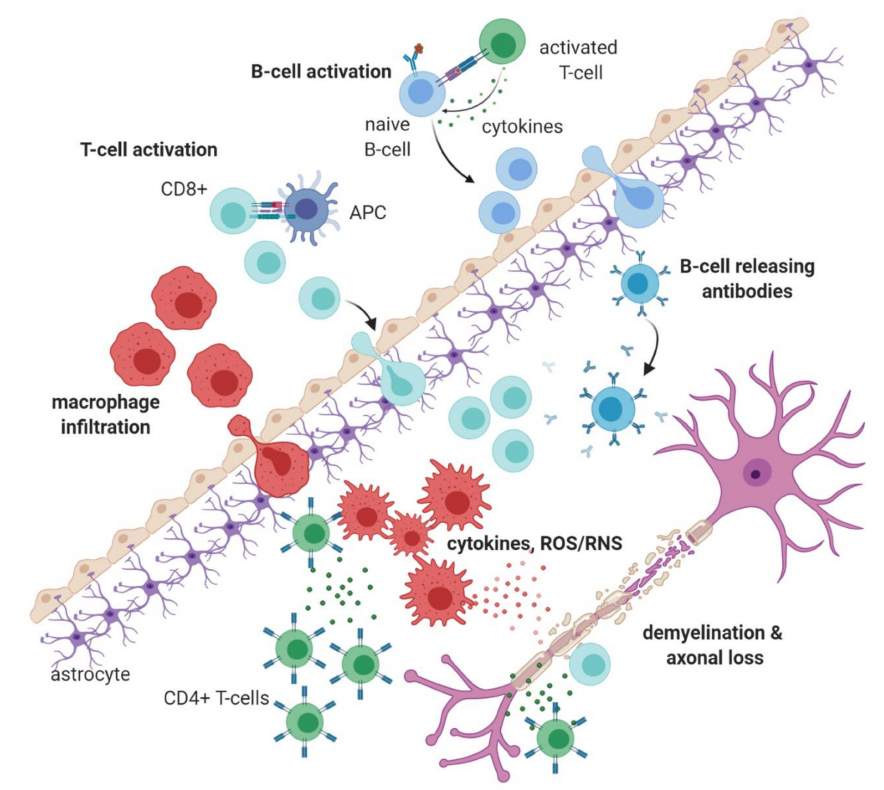
Figure 1. An outline of MS immunopathology: MS results from breakdown of the blood-brain barrier (BBB) leading to migration of immune cells into the central nervous system (CNS). These immune cells secrete a range of pro-inflammatory cytokines as well as reactive oxygen and nitrogen species (ROS / RNS), which induce inflammation, formation of sclerotic plaques (lesions), demyelination and axonal degradation. Pathological immune cells in MS include innate immune cells like activated macrophages and resident microglia, autoreactive T-cells (that are activated at peripheral sites, potentially through molecular mimicry, bystander activation or the co-expression of T-cell receptors (TCRs) with di ff erent specificities [2]) and antibody producing B-cells. (APC: Antigen-presenting cell); Image made in Biorender TM